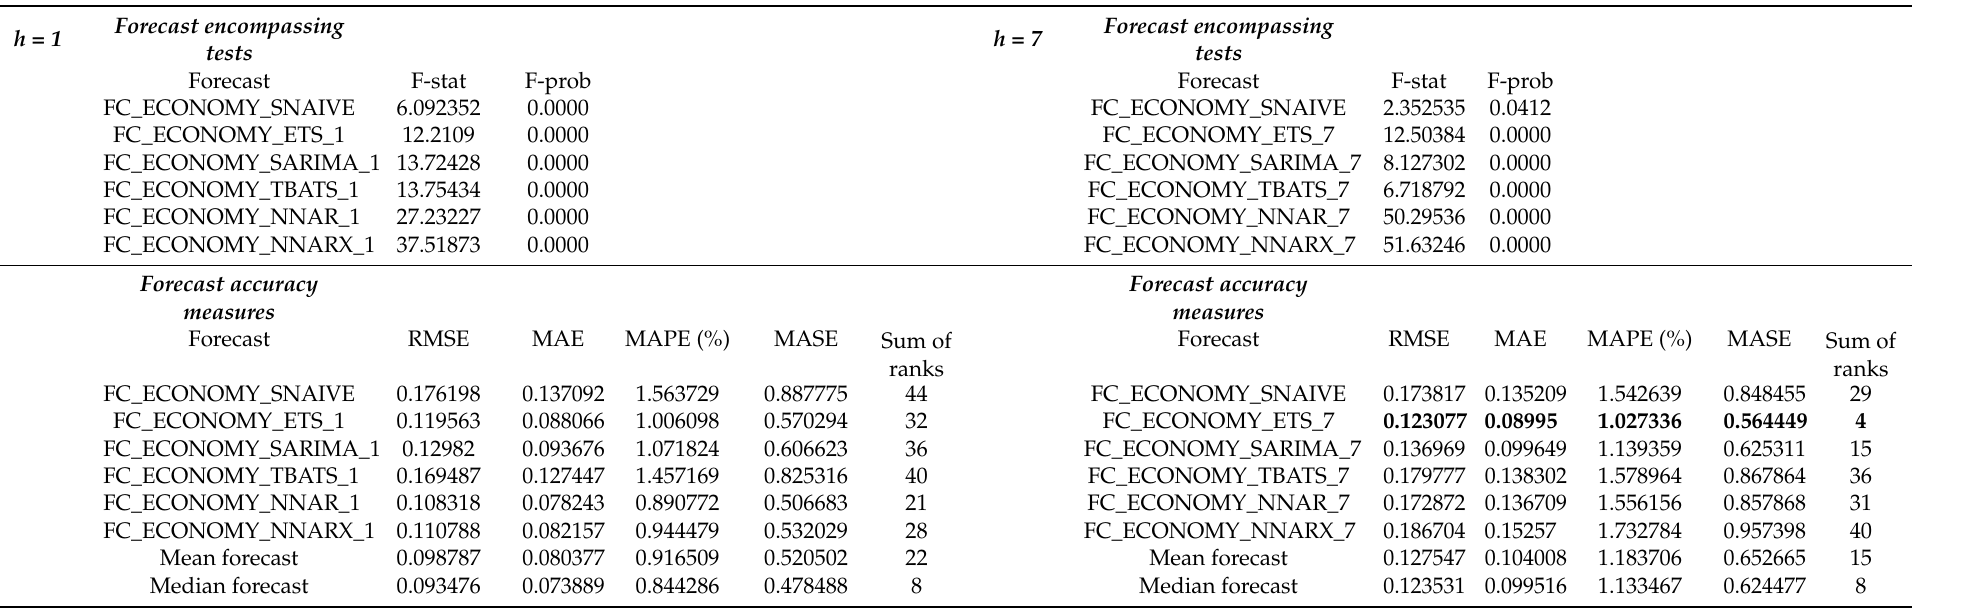
Table A6. Forecast evaluation results for the hotel class ‘economy’. Source: STR SHARE Center, own calculations using R and